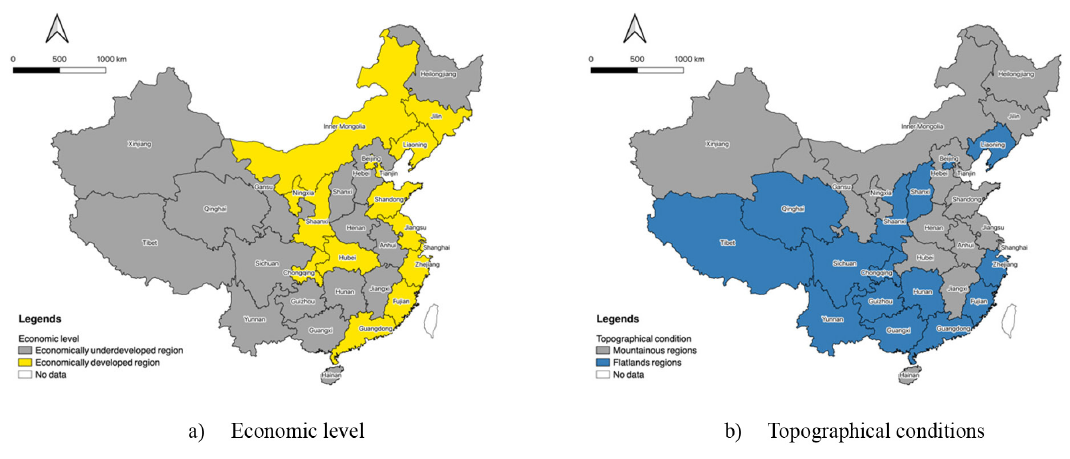
Figure 4. Regional division of provinces in China